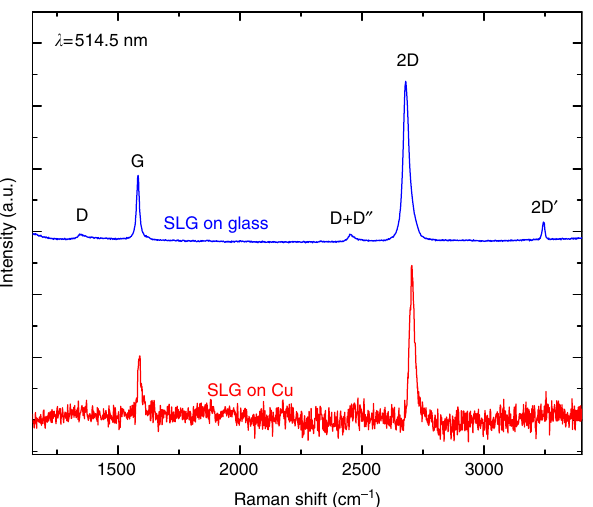
Fig. 5 CW Raman spectra of SLG. Raman response of SLG on Cu (red line), and on glass (blue line) after the transfer from Cu. In the latter case, the substrate spectrum is subtracted